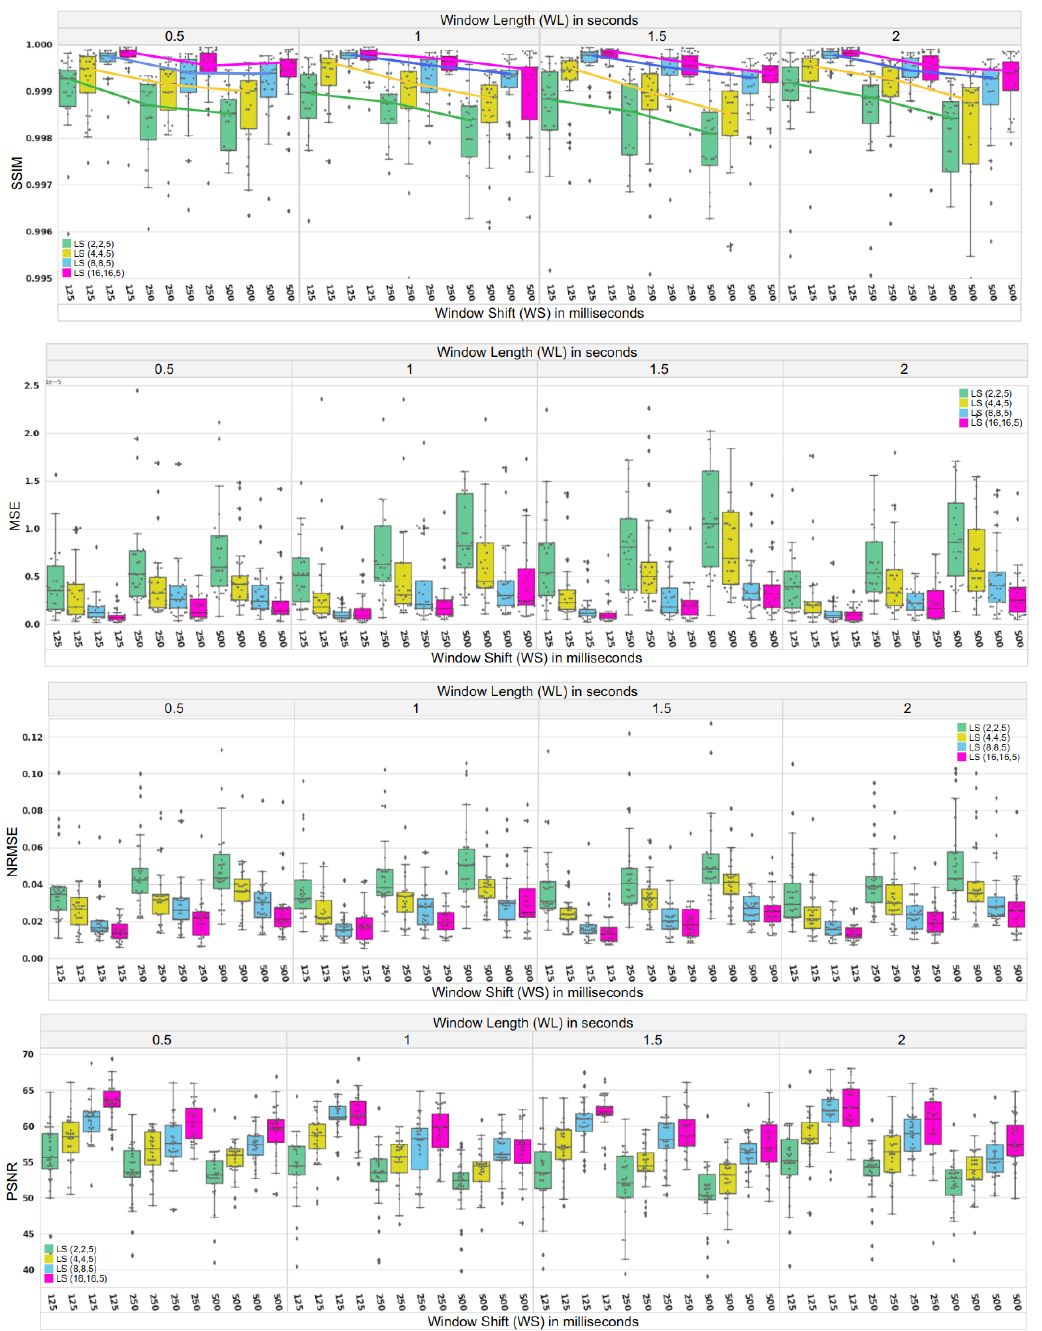
Figure 4. Reconstruction ability, as measured by Structural Similarity Index (SSIM), Mean Squared Error (MSE), Normalised Root Mean Squared Error (NRMSE), and Peak Signal-to-Noise Ratio (PSNR) for 48 different ConvAE models with varying window length (WL), window shift (WS), and latent space